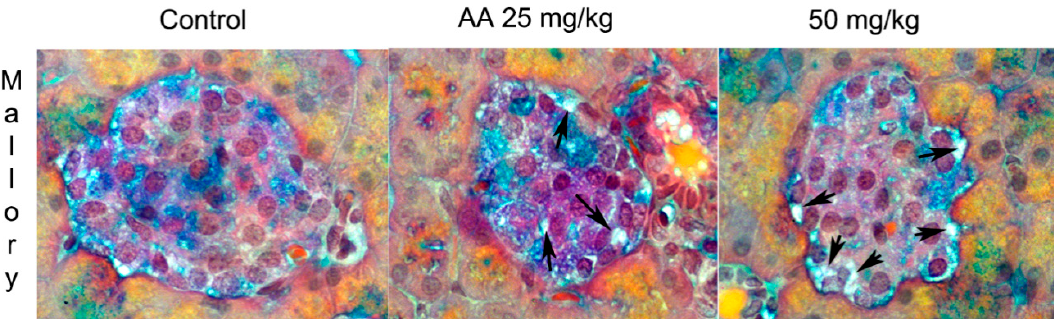
Figure 5. Mallory-Azan-stained pancreatic islets of control and AA-treated rats. Male Wistar rats were treated with AA in doses of 25 mg/kg b.w./d and 50 mg/kg b.w./d. Black arrows show dilated blood vessels; 400× light microscope magnification [72].